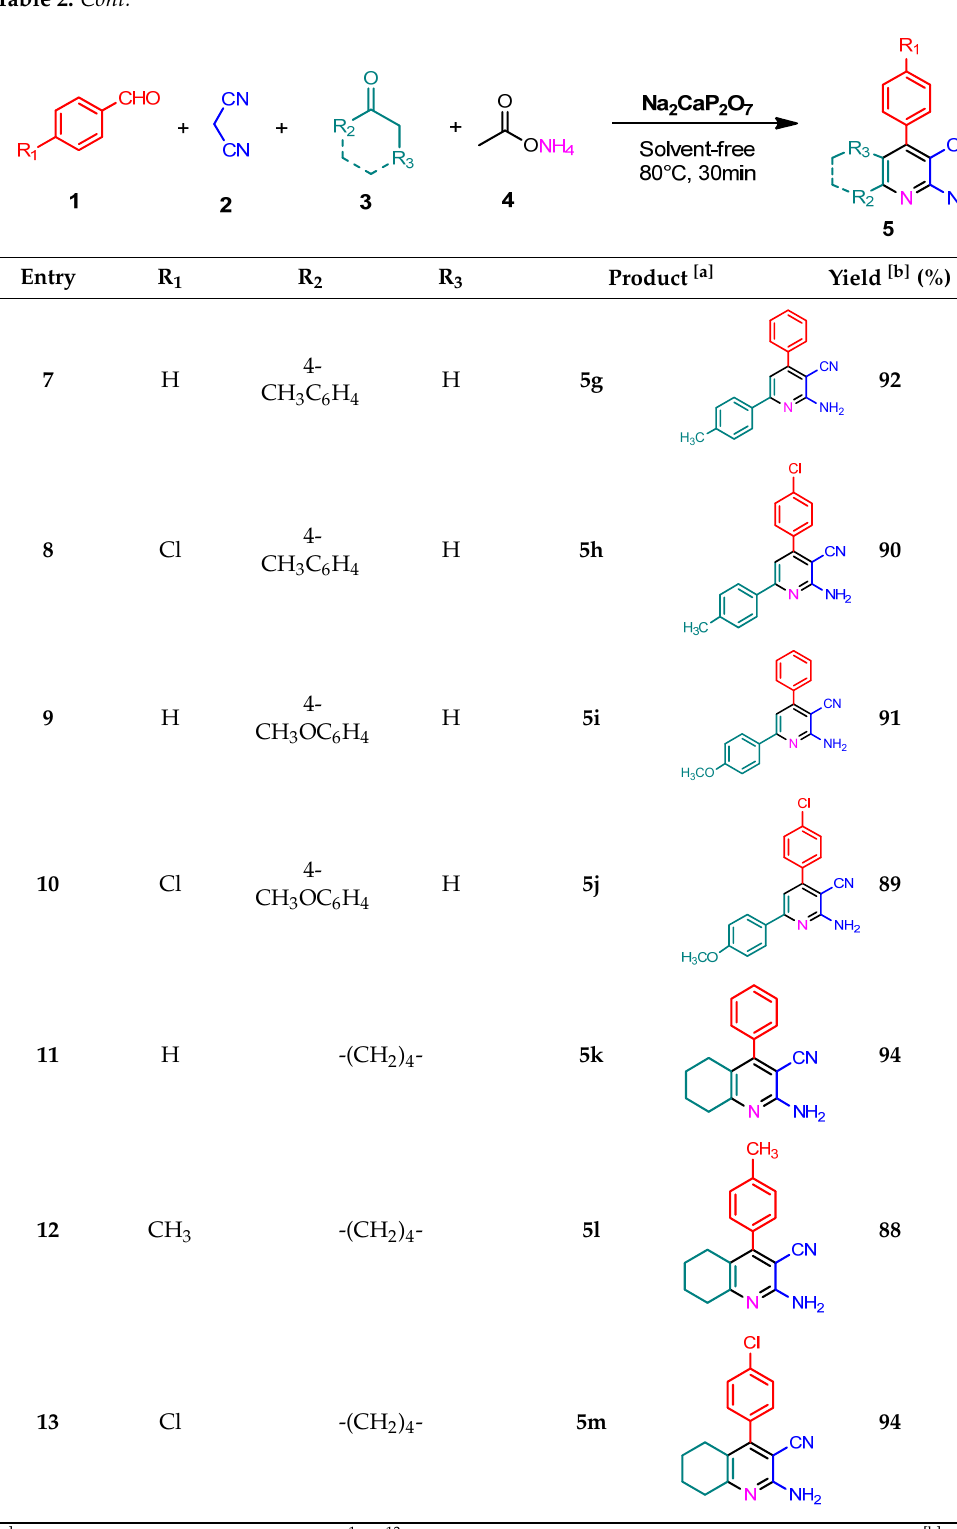
Solvent Figure 7. Influence of the solvent in the catalytic synthesis of 2-amino-3-cyanopyridine 5a . After determining the optimal conditions for the synthesis of 2-amino-3- cyanopyridine 5a, the reactions of different aromatic aldehydes containing substituents in the aromatic ring, such as Me, OMe, Cl, and NO 2 , with malononitrile 2 , acetophenone derivatives, or cyclohexanone 3 and ammonium acetate 4 were carried out under identical